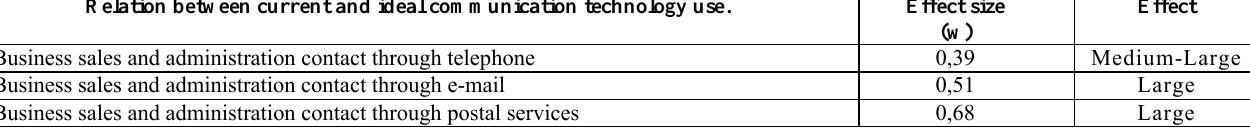
Table 5: Relation between current and ideal communication technology usage Relation between current and ideal communication technology use.